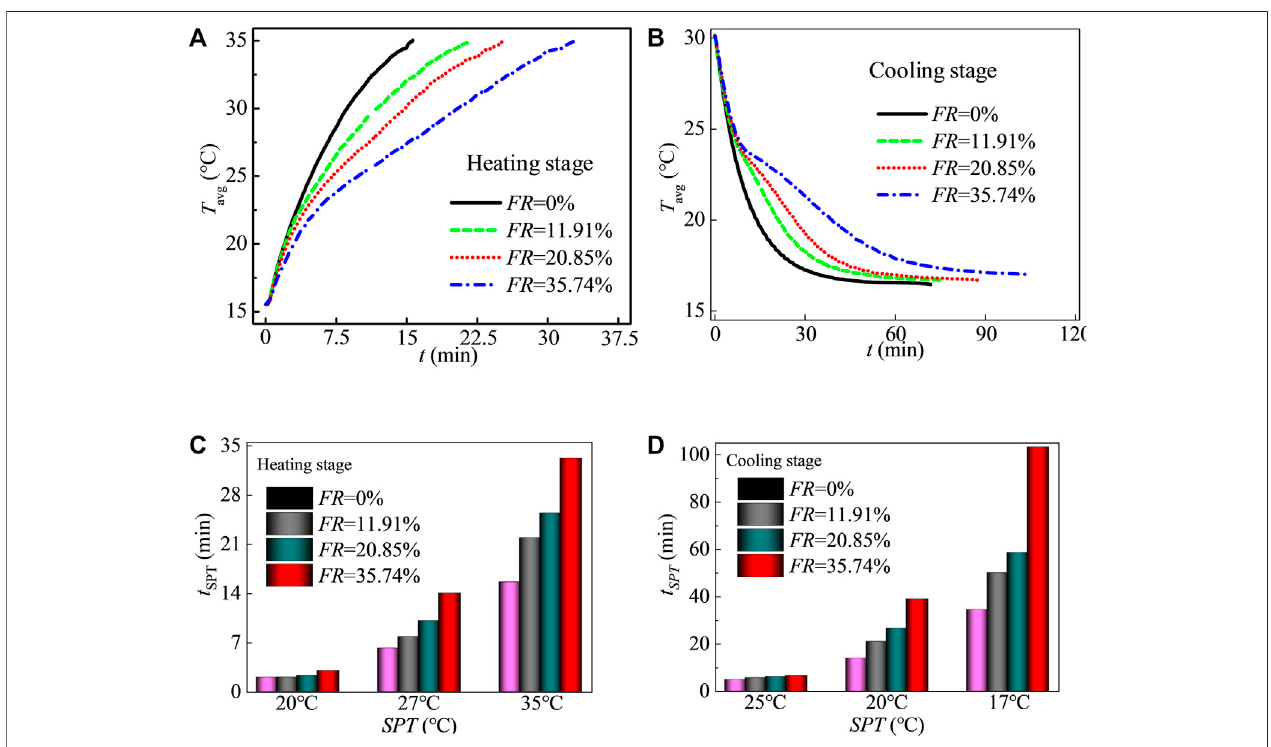
FIGURE 4 | Thermal performance of the model house with different FRs : (A) temperature distributions inside the model house during the heating stage; (B) temperature distributions inside the model house during the cooling stage; (C) time required for the model house to reach SPTs during the heating stage; (D) heating stage; (B) time required for the model house to reach SPTs during the cooling